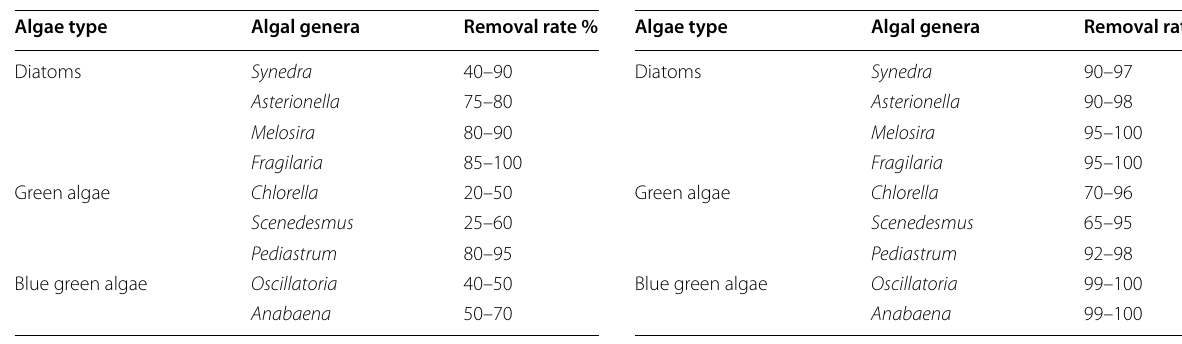
Table 5 Removal rate for algae after